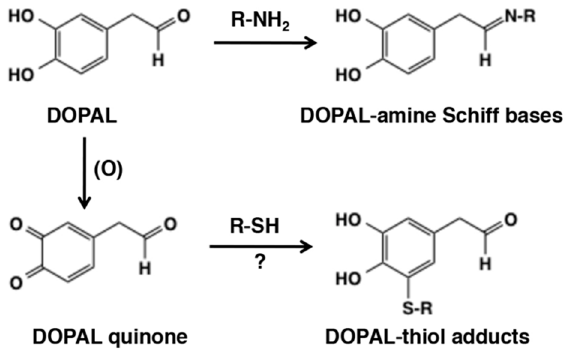
Figure 25. Reaction of 3,4-Dihydroxybenzaldehyde (DOPAL) and its quinone with amines and thiols [131]. Note that the reaction with thiols requires oxidation to the quinone form.